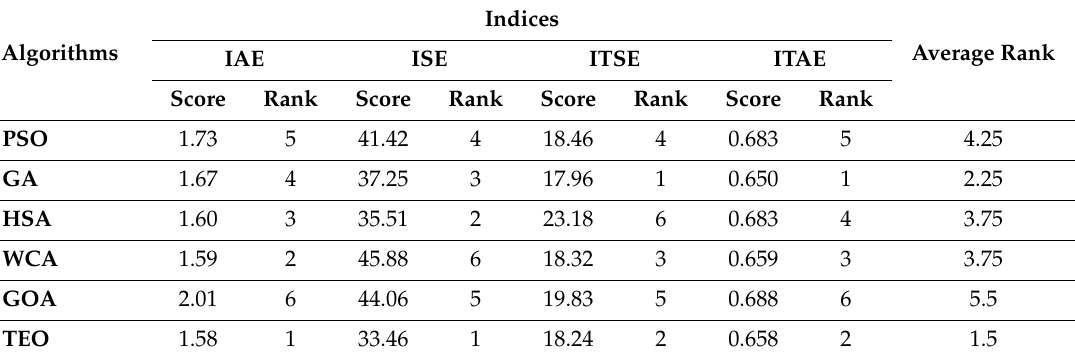
Table 6. Average Rank based statistical analysis of mean